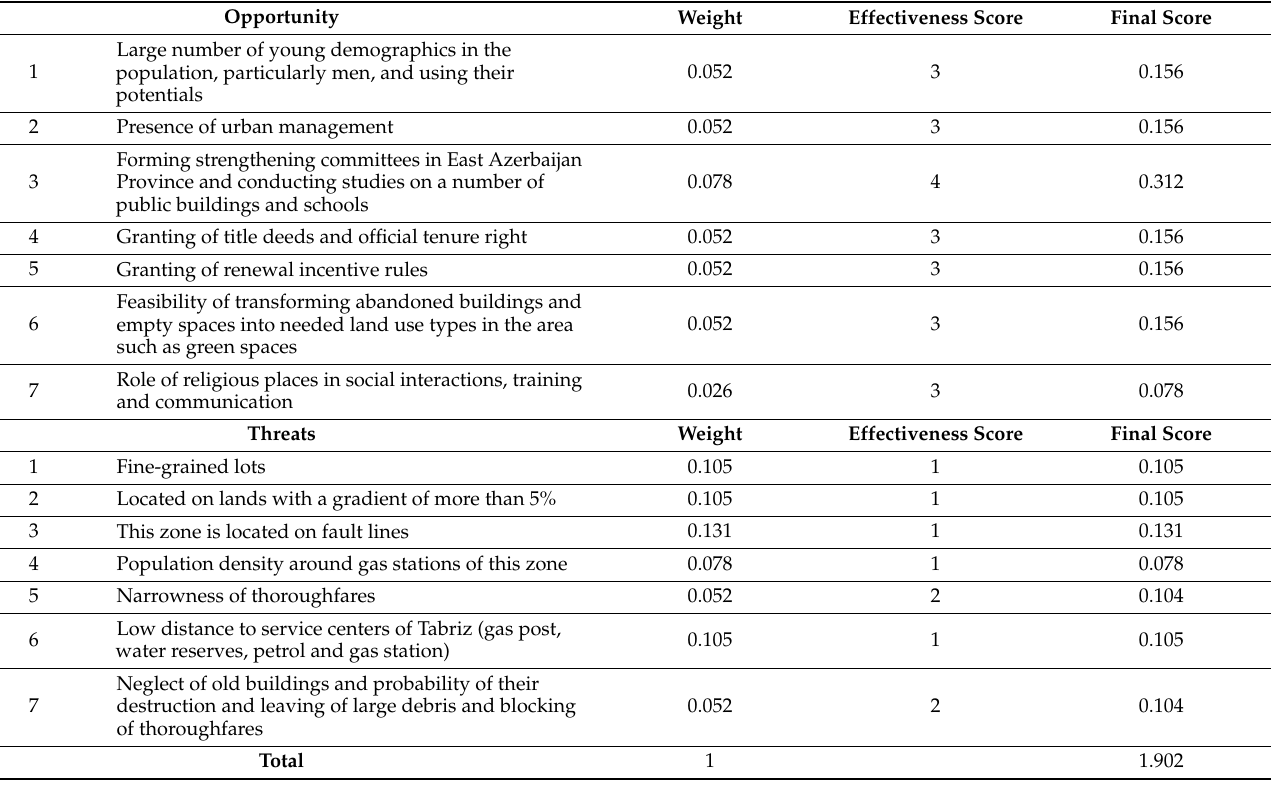
Table 15. External Factor Evaluation (EFE).